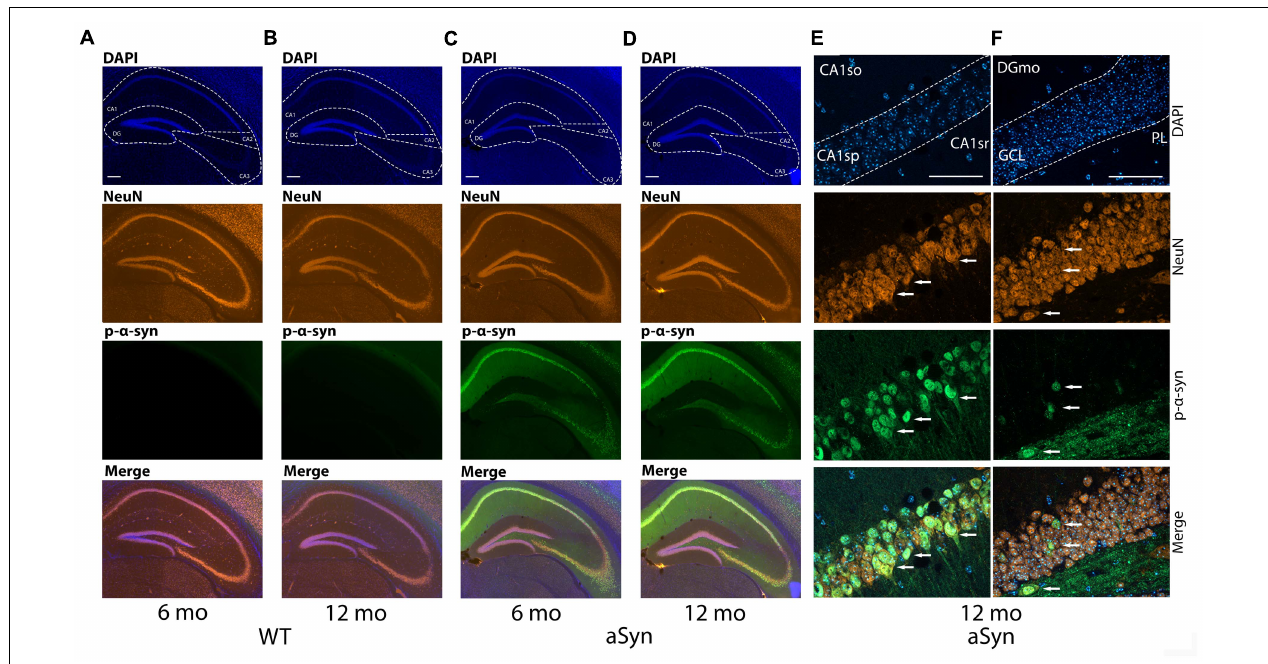
FIGURE 1 | Expression of the p- α -syn in the hippocampus of the 6 and 16-month-old WT and Thy1-aSyn mice. Double-immunofluorescence for p- α -syn (green) and NeuN (orange) and DAPI staining (blue) and merged images of 6 and 16 months-old wildtype [WT; (A,B) ], and 6 and 16 months-old Thy1-aSyn [asyn; (C,D) ] mice. Cornu ammonis (CA1, CA2, and CA3), dentate gyrus (DG) regions. Scale bars, 200 µ m. High magnification Apotome images (63 × , oil immersion), double-immunofluorescence for p- α -syn (green) and NeuN (orange) and DAPI staining (blue) and merged images of Thy1-aSyn mice (E,F) . CA1so, CA1 stratum oriens; CA1sr, CA1 stratum radiatum; CA1sp, CA1 pyramidal layer (E) , GCL, DG granule cell layer; DGmo, DG molecular layer; PL, DG polymorph year (F) . Arrows indicate NeuN positive cells and p- α -syn accumulations. Scale bar 50 µ m.